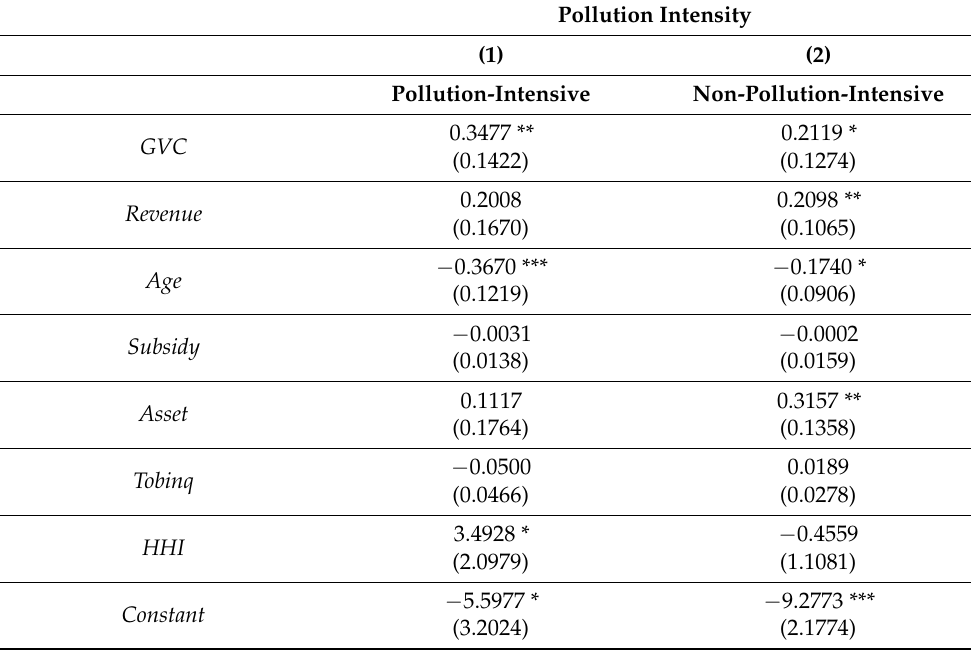
Table 7. Industry heterogeneity analysis: Pollution